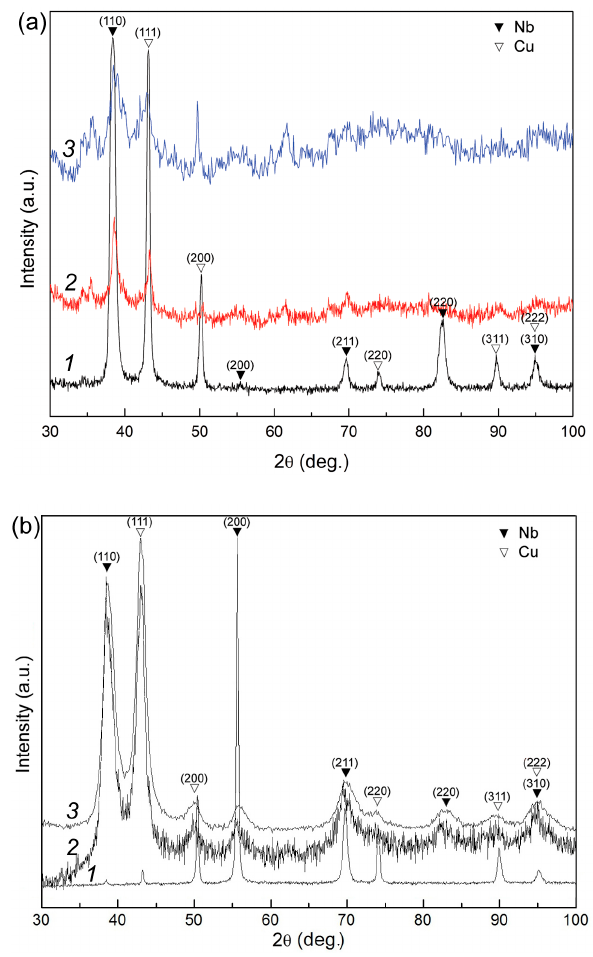
Figure 16. XRD spectra of the initial Cu-Nb nanolaminate 1 – N = 0 and after HPT to 2 – N = 2 and 3 – N = 4 : ( a) plane of sample, ( b) end face of sample.